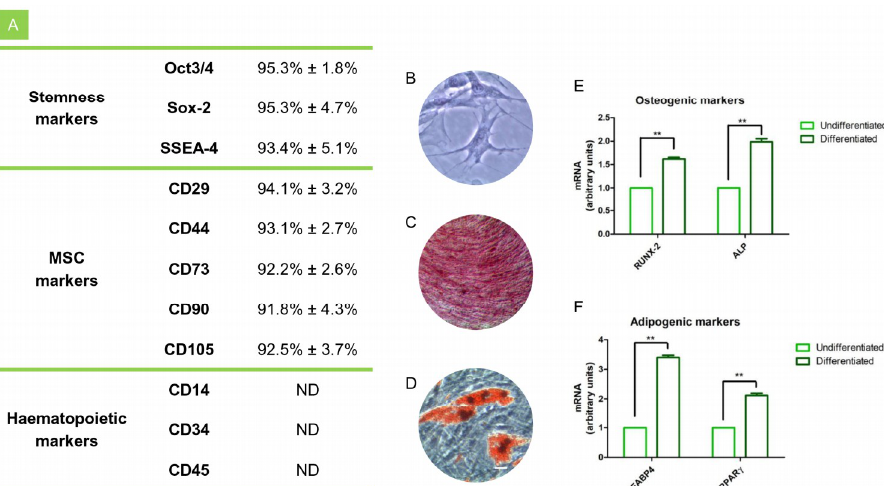
Figure 1. hPDLSCs characterization. ( A ) Cytofluorimetric analysis of hPDLSCs. ( B ) Plastic adherent hPDLSCs stained with toluidine blue solution. ( C ) Osteogenic differentiated hPDLSCs stained with Alizarin Red solution. ( D ) Adipogenic differentiated hPDLSCs stained with oil red solution. ( E ) RT‐PCR of osteogenic related markers in undifferentiated and differentiated cells. ( F ) RT‐PCR of adipogenic related markers in undifferentiated and differentiated cells. ** p < 0.01. Scale bar: 10 µm.